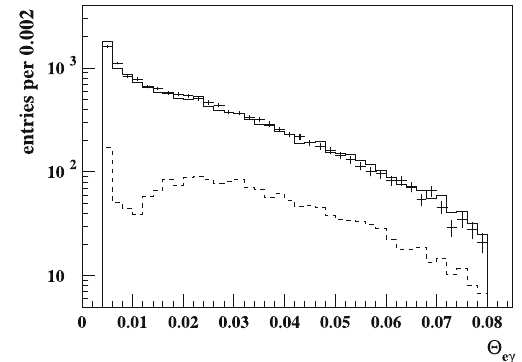
Fig. 4 The distribution over (cid:5) e γ - the angle between positron and photon in lab. system. Real data (points with errors), signal plus MC background (solid line histogram), MC background (dotted line his- togram) occurs in the setup material downstream the decay vertex, but the angle is still calculated as if emission comes from the vertex. Cut 6: 0 . 004 < (cid:5) e γ < 0 . 080 rad. The left part of this cut is introducedexactlyforthesuppressionofbackground (1). The right cut is against K π 2